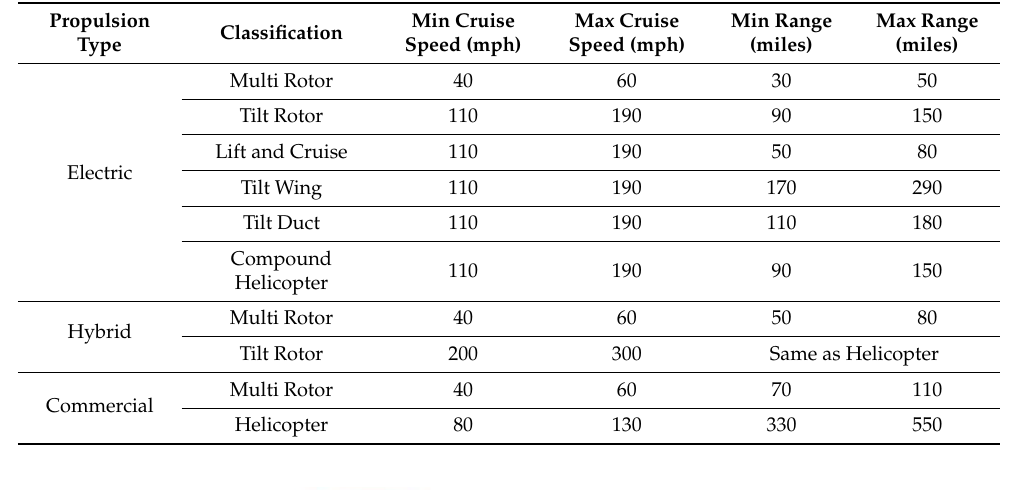
Table 4. Aircraft/Rotorcraft performance assumptions.